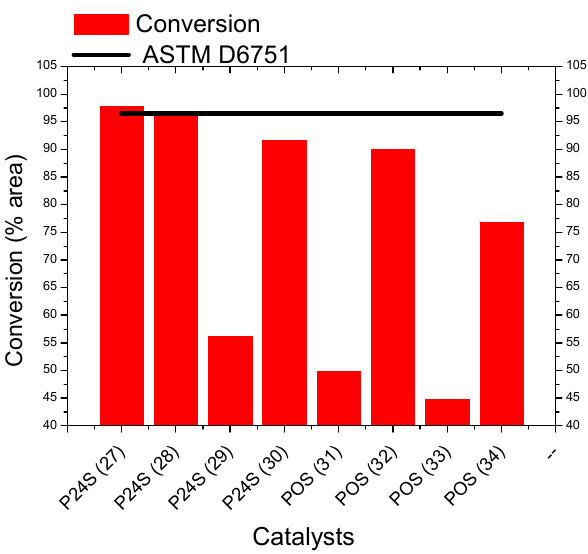
E = Experiment; C = Catalyst; FS = Fatty source; A = Alcohol; CR = Conversion rate (% área); P24S = poly(2,4-dihydroxy-5-sulfo-benzoic acid); POS = poly(2-hydroxy-5-sulfo-benzoic acid); PPS = poly(4-hydroxy-5-sulfo- benzoic); TS = Tallow swine; SO = Used sauteing oil; MeOH = Methanol; EtOH = Ethanol. Oligocat catalysts were evaluated in comparison with Lewatit SPC 112 regarding the conversion of alkyl esters. Catalysts POS and P24S presented better efficiency for the optimized experimental reactional conditions, and PPS catalyst does not present significant rate conversions. Figure 10 depicts conversion rates of Oligocat POS and P24S catalysts and the minimum conversion rate imposed by ASTM D6751.